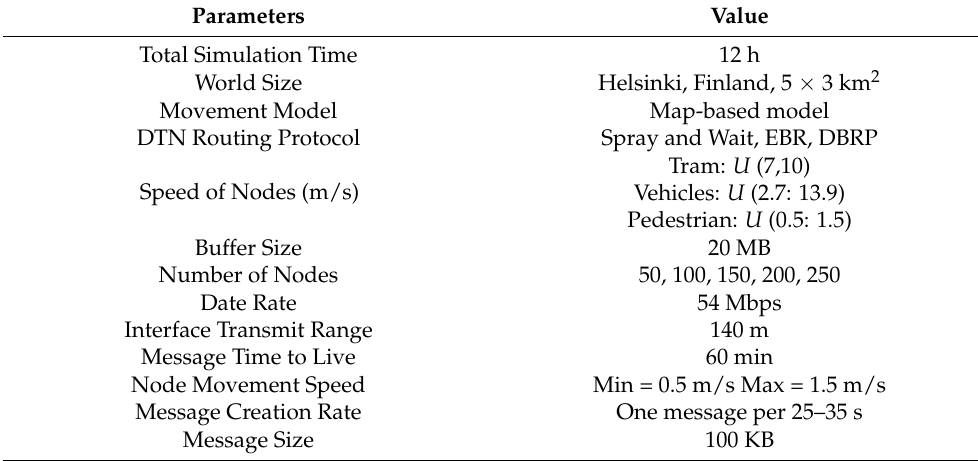
Table 2. Parameters of the simulation